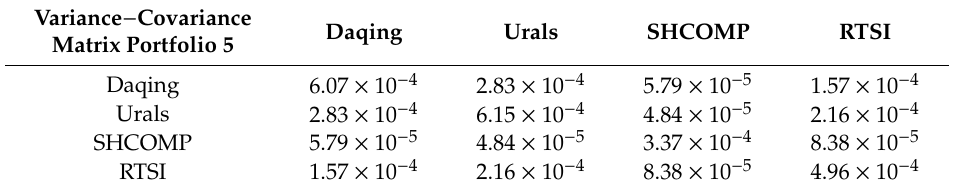
Table A29. Maximum Likelihood Variance–Covariance Matrices for portfolio 5: Daqing, Urals, SHCOMP, RTSI. Elaborated by authors with data from Bloomberg.